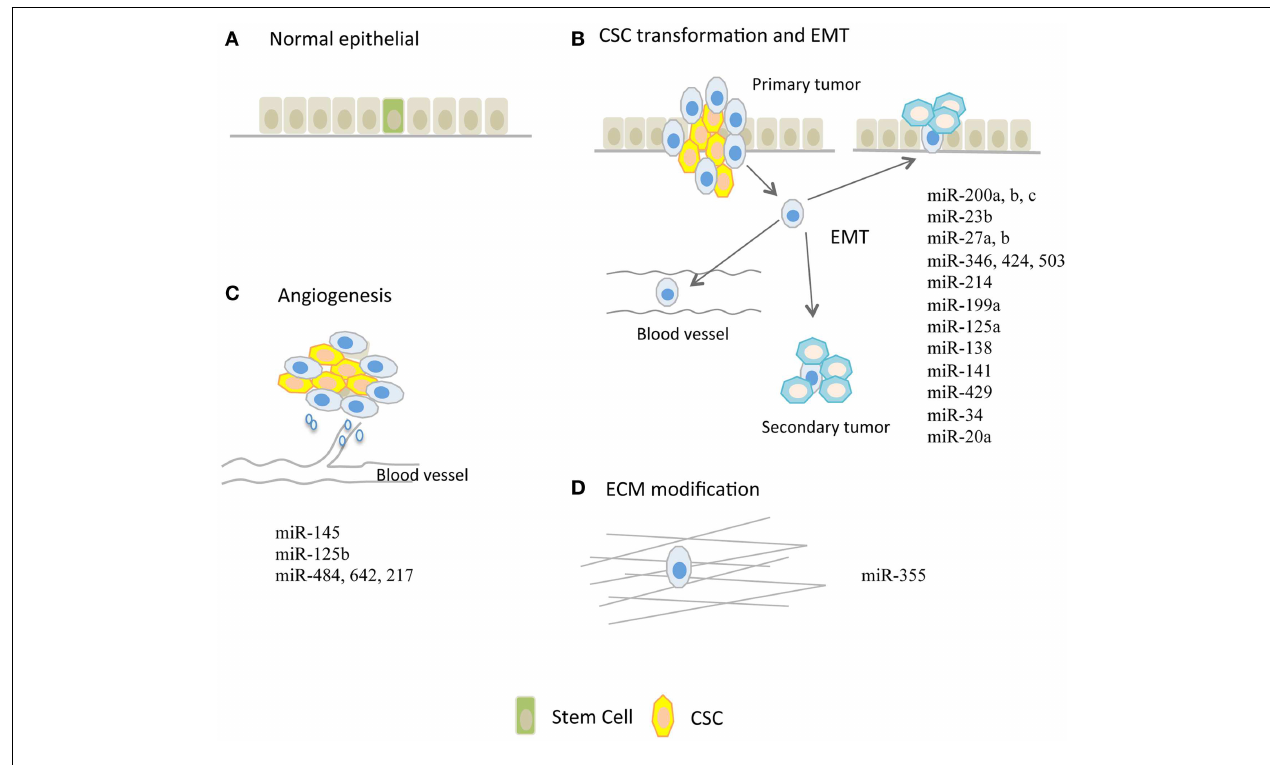
in tumor angiogenesis.Tumor angiogenesis, which is required for further tumor growth, is proven to be a handy process that facilitates tumor metastasis. (D) miR-355 that increases cell–extracellular matrix (ECM)